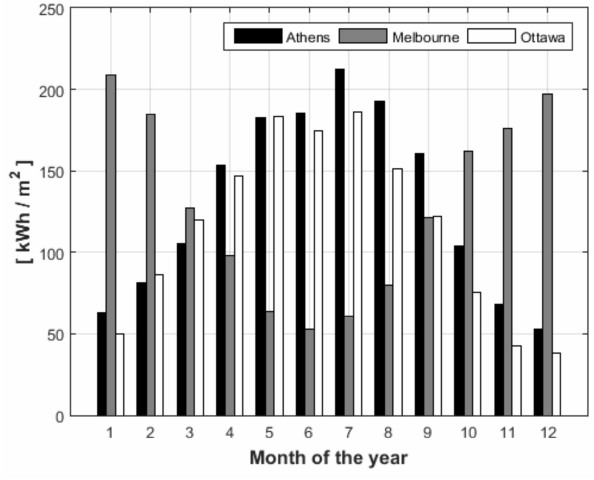
Figure 2. Monthly global horizontal solar energy for all three cities. (Derived from TMY2, Meteonorm). The main components of a SAGSHP system are the PVT array, the earth energy bank (EEB), and the heat pump. The EEB is comprised of the GHE and the adjacent soil volume, in other words, this is the long-term solar heat storage element of the system. The analysis of the system along with the dwellings is illustrated in Section 2.1, while the topology of the system is shown in Figure 3. A combined mathematical model of the SAGSHP system and of the dwelling was formulated in the TRNSYS simulation platform [38]. With the developed model, simulation-based parametric analyses were conducted by varying the size of the PVT array and of the EEB. Based on that, twenty-five simulations were carried out for each city, with five different sizes of the PVT array and five different sizes of the EEB, Section 2.1.